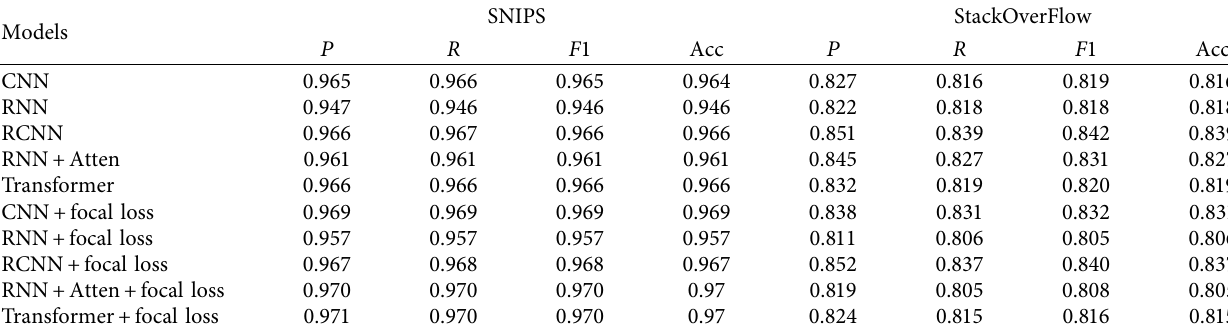
Table 5: The results of model comparison on the two English datasets.